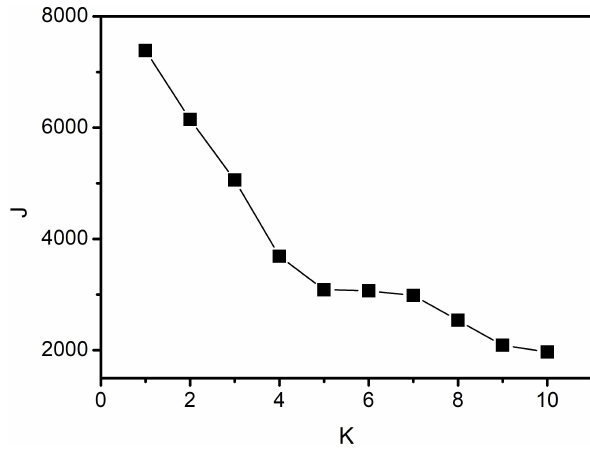
Figure 10: Clustering validity analysis for In-situ tensile